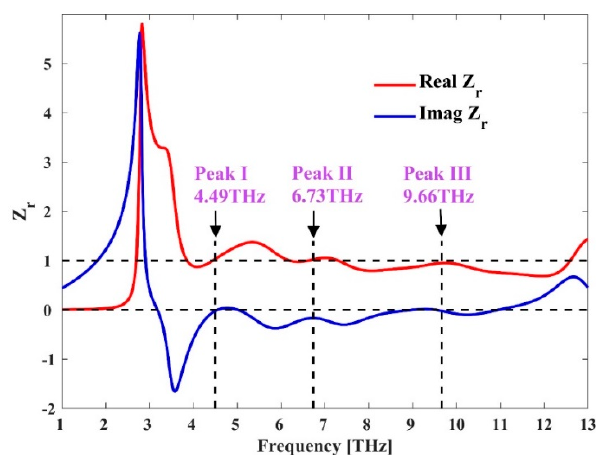
Figure 6. Real and imaginary parts of the relative impedance Z r .